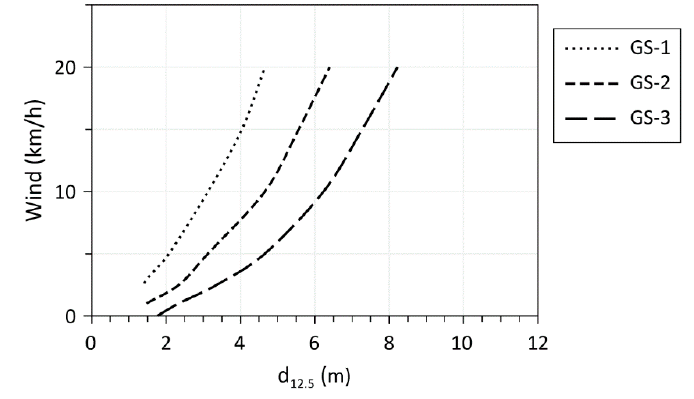
Figure 9. Safe separation distances as a function of wind speed at Low MC (D2L2) for GS fuel mod- els.